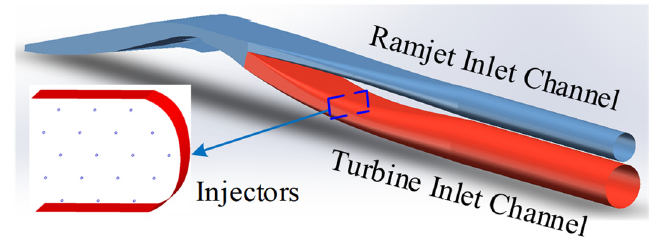
Figure 2. The baseline of the TBCC inlet.